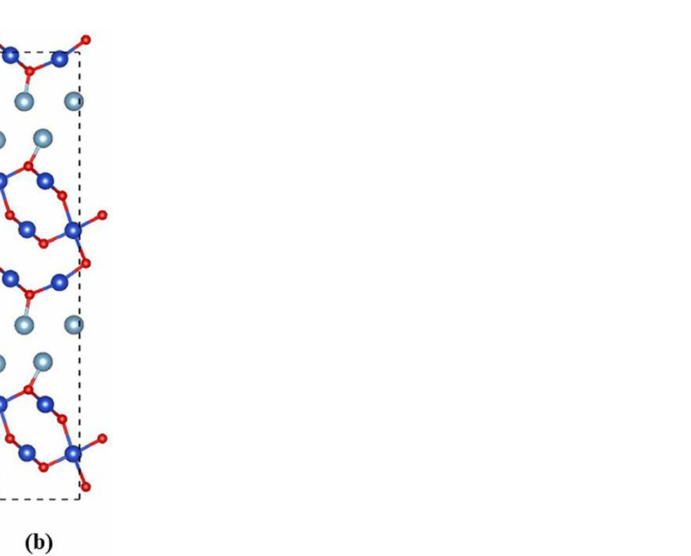
Figure 3. Side view of the initial configuration of ( a ) one-modulation-period structure and ( b ) two- modulation-period structure Al/CuO energetic composite films. The pale blue, blue, and red spheres represent Al, Cu, and O atoms, respectively.